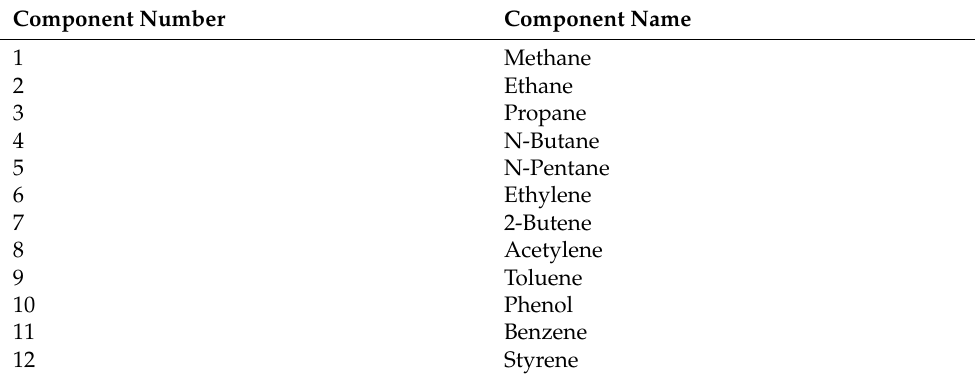
Table 2. Organic components included in the